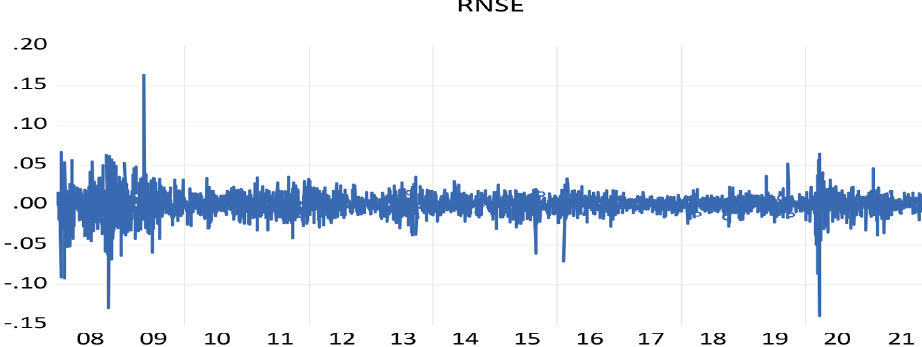
Figure 1. The volatility clustering of NSE return (source: author ’ s calculation). NSE: National Stock Exchange; RNSE: returns of